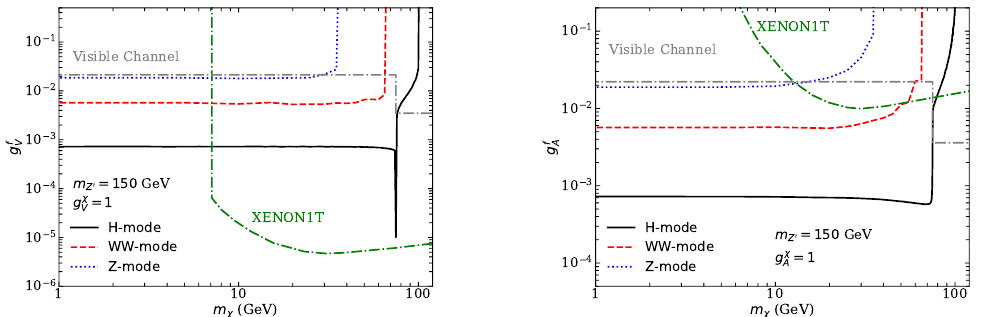
Figure 13 . Expected CEPC limits on g f (left), and on g f (right), in the Z 0 portal DM model V A where M Z 0 = 150 GeV, from the monophoton channel e + e (cid:0) ! (cid:13)Z 0 ! (cid:13) (cid:22) (cid:31)(cid:31) in the three CEPC running modes. On the left (right) panel plot, only vector (axial-vector) couplings are assumed, with g (cid:31) = 1 (left) and g (cid:31) = 1 (right). Also shown are limits from e + e (cid:0) ! (cid:13)Z 0 ! (cid:13)(cid:22) + (cid:22) (cid:0) in the V A H -mode, from SI limit [53] (left) and SD limit [51] (right) in Xenon1T.